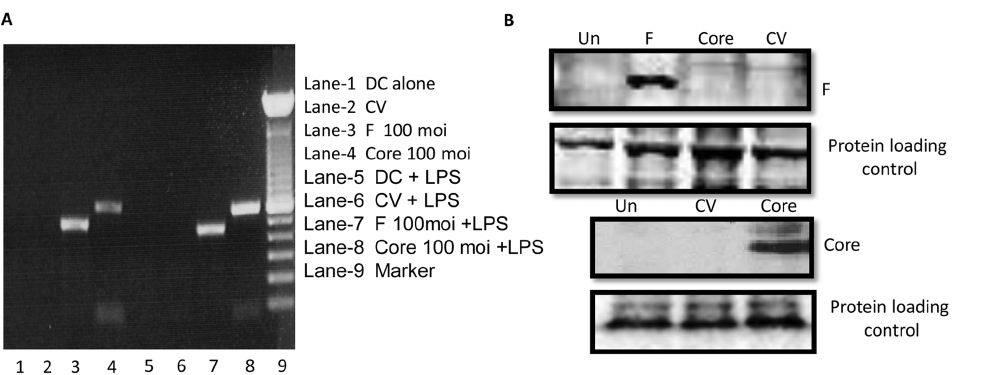
Figure 1. Expression of HCV F or core antigens in DCs infected with recombinant adenovirus containing HCV F or core. Panel A. mRNAexpressionbyRT-PCR. DCswereinfectedwithrAd-ForrAd-coreatanm.o.i.of100.After48hoursofinfection,DCswereharvested,mRNAwas extracted, and cDNA was produced as described in Materials and Methods followed by amplification of F or core specific genes. F and core specific genes were expressed in both immature (lanes1–4) and LPS-matured DCs (lanes 5–8). Controls included DCs alone (lanes 1 and 5), and CV treated DCs (lanes 2 and 6). Panel B. Protein expression by Western blot. DCs were infected with rAd-F (lane 2) at m.o.i. 100 or left uninfected (lane 1); a control was infected with rAd (lane 4). 293A cells infected with rAd-core at an m.o.i. of 100 were used as negative (lane 3 of top panel) and positive control (lane 3 of the third panel), respectively. Cells were harvested 48 hours after infection. Expression of the F protein (17 kDa) was monitored by using a specific mAb against F, which precipitated a band of around 17 kDa from rAd-F infected DCs, corresponding to the putative molecular mass of HCV F. Anti-core antibody precipitated a band of , 21 KDa from rAd-core infected DCs (third panel). b -tubulin was used as protein loading control. cells (Fig. 5A, left panel and Fig. 5B). In accordance with the CD- 95L expression, apoptosis, as measured by Annexin V and 7-AAD staining, was enhanced in THP-1 cells infected with adenovirus vector expressing F protein, compared to control vector or untreated cells (Fig. 5A, right panel and Fig. 5C).